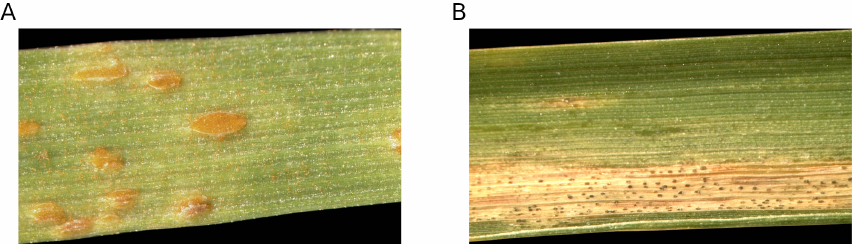
Figure 1. RGB images of the symptoms of ( A ) brown rust caused by Puccinia triticina and ( B ) septoria tritici blotch caused by Zymoseptoria tritici . Brown rust symptoms are dominated by reddish spore stocks whereas necrotic lesions are characteristic for septoria tritici